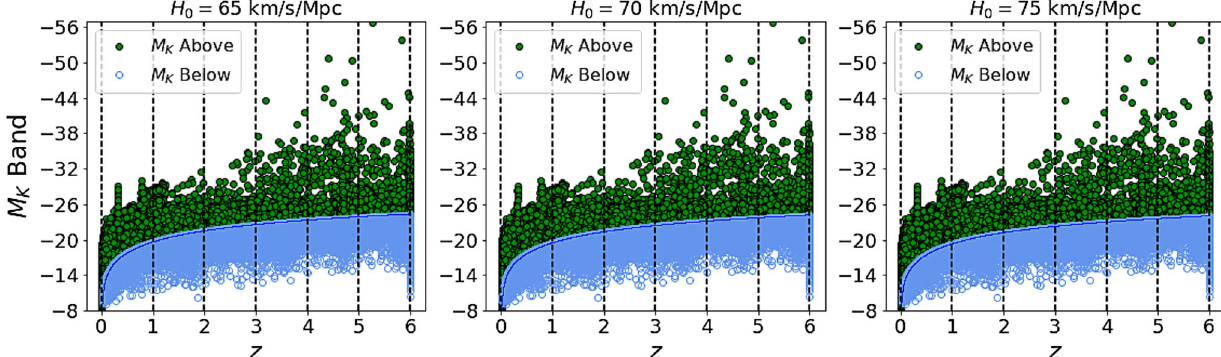
Fig. 3 Plot of the absolute magnitudes for the SPLASH galaxies in terms of of their photometrically measured redshift values. The divid- ing line corresponds to apparent magnitude K = 24 . 7 and only galaxies